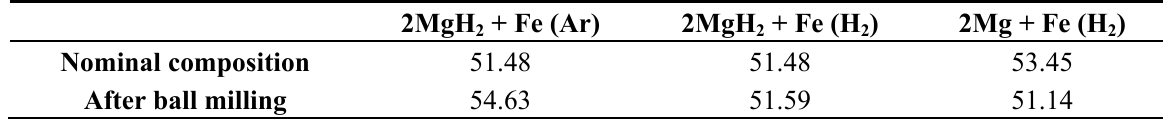
Table 1. Iron concentration (wt. %) of ball milled samples measured by atomic absorption spectrometry. The nominal composition before ball milling is also presented for